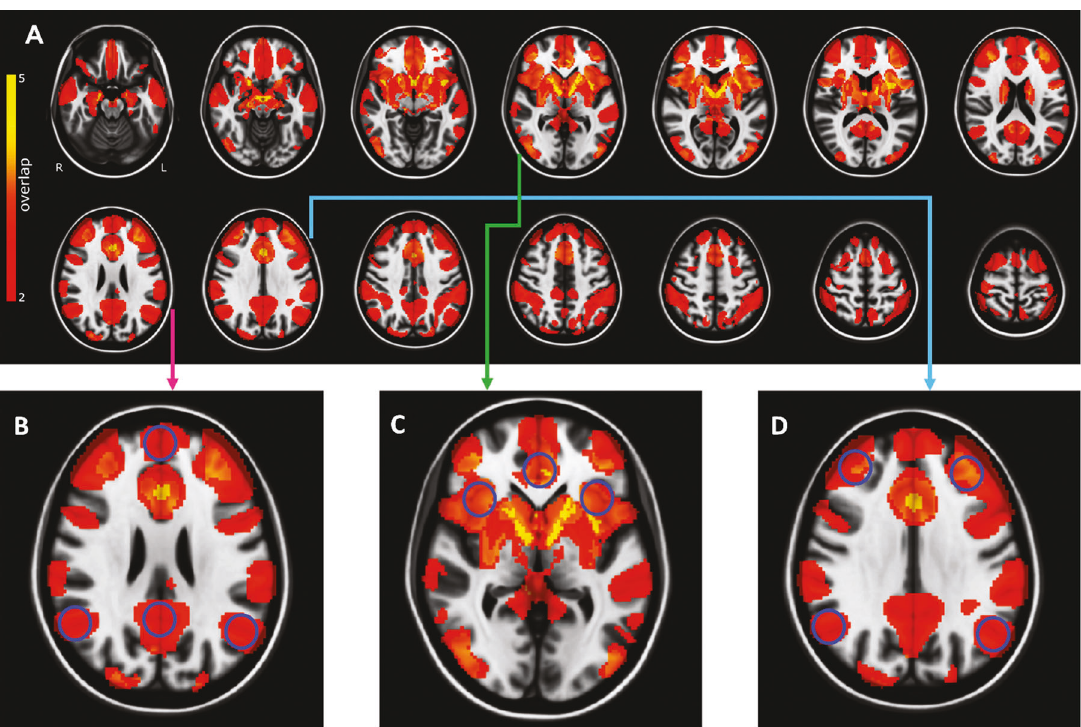
Fig. 5 Normative functional connectivity networks for DBS and non-invasive neuromodulation. A . Voxels associated with DBS and non- invasive neuromodulation were signi fi cantly ( P Bonferroni < 0.05 ) correlated with Papez circuit (4 out of 5 (80%) overlap of stimulated